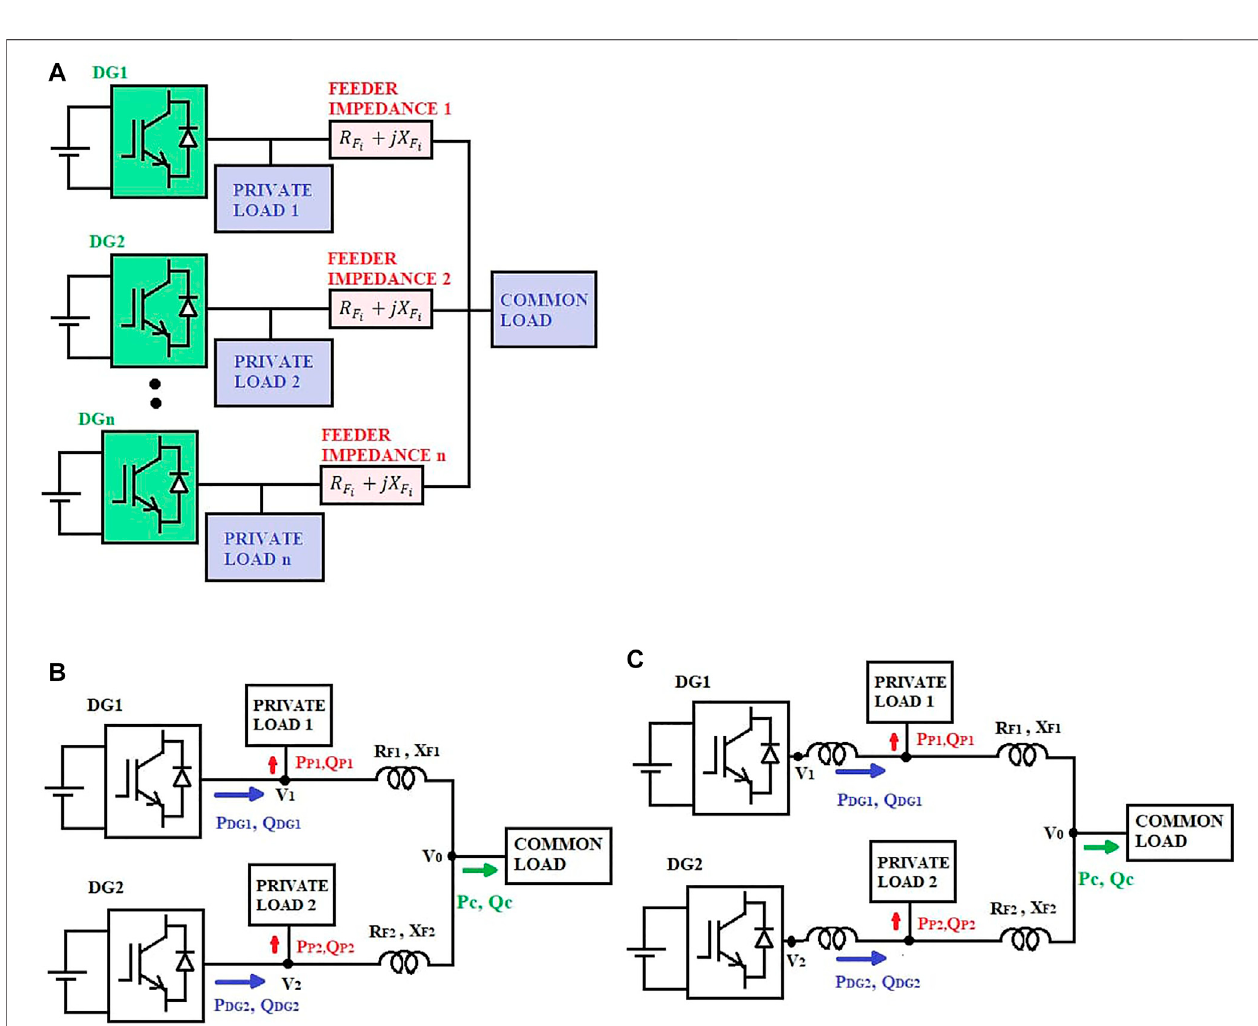
FIGURE 1 | Microgrid (MG) for the investigation of reactive power sharing: (A) con fi guration of the MG considered, (B) power fl ow without virtual impedance, and (C) power fl ow with virtual impedance.